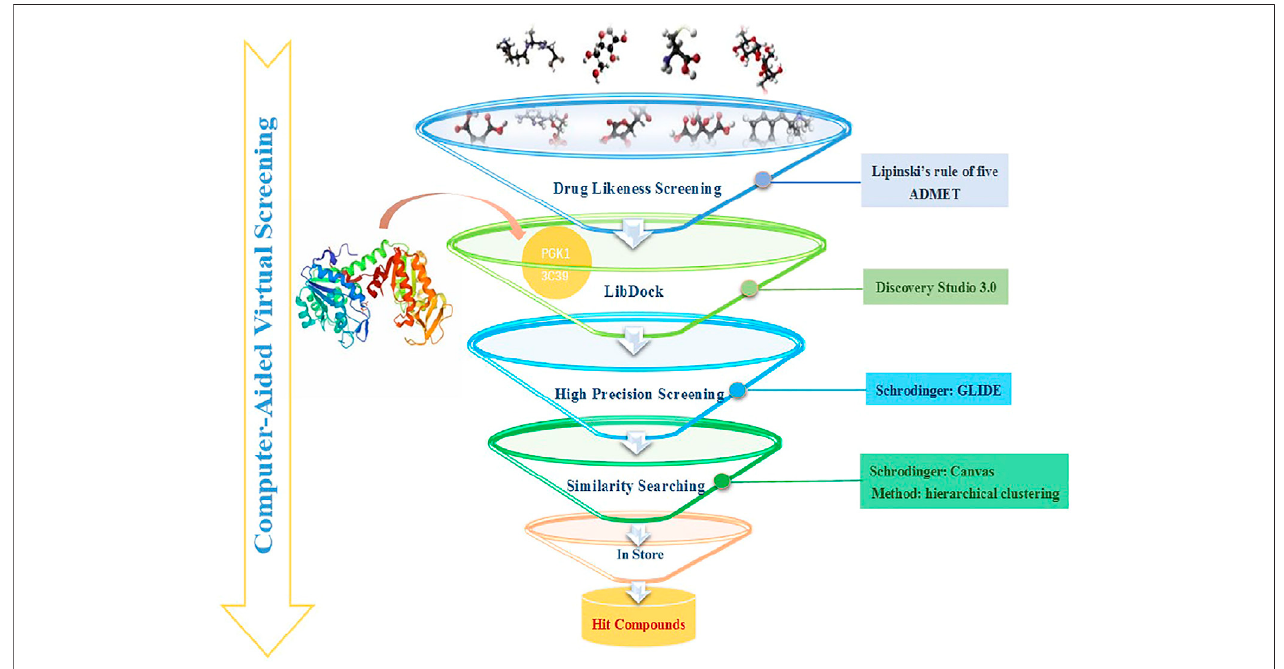
FIGURE 1 | Virtual screening fl ow